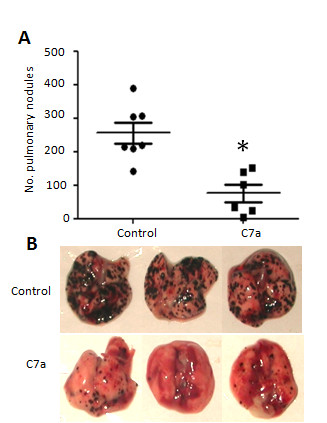
Antimetastatic activity of C7a. C57Bl/6 mice injected endovenously with B16F10-Nex2 cells were treated i.p. with C7a. (A) Number of pulmonary nodules 15 days after tumor inoculation, each symbol represents one individual animal. Horizontal lines represent the average and standard deviation; (B) Representative images of lungs from treated (C7a) and untreated (Control) animals. * p < 0.05. Results are representative of 3 independent experiments.